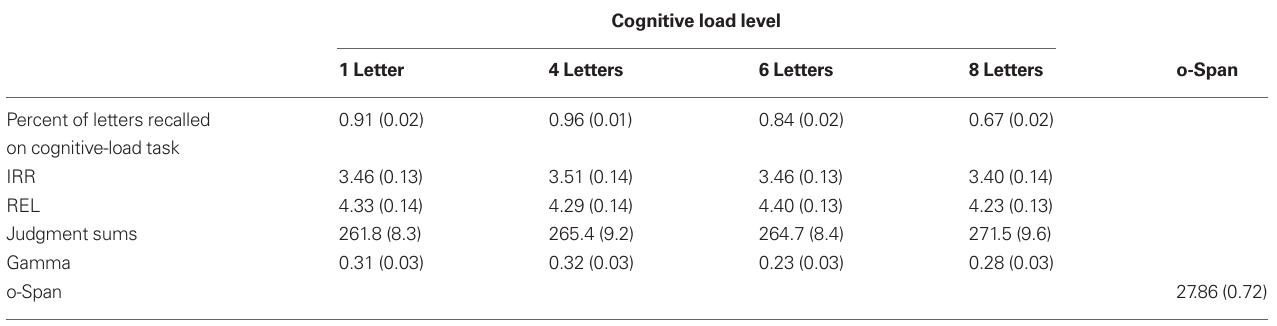
Table 2 | The mean number of relevant and irrelevant alternatives identified in the implicit memory task as a function of cognitive-load level, the percentage of letters recalled in the cognitive-load task as a function of cognitive-load level, mean judgment sums as a function of cognitive-load level, mean gamma correlations as a function of cognitive-load level, and mean operation-span scores for experiment